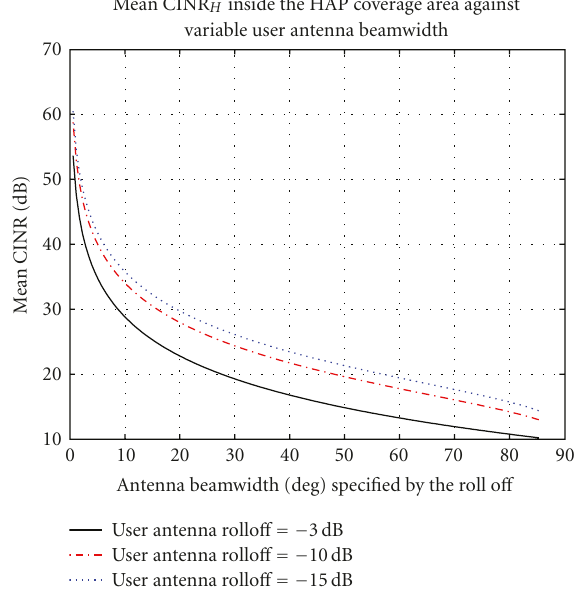
Figure 10: CINR H performance against increased user antenna